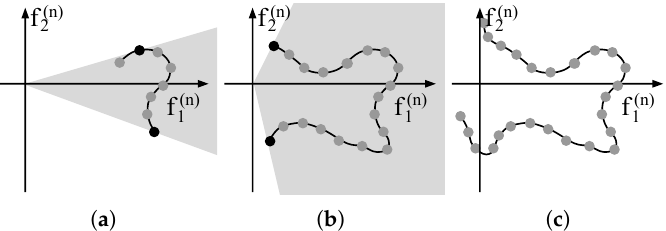
Figure 4. ( a ) illustrative case of projection of local manifold samples M ( n ) on a basis B ( n ) , for K = 2. The curved line represents the projection of a continuous one-dimensional manifold, while the dots represent the projection of the samples (columns of M ( n ) ) on B ( n ) . When ∆ is sufficiently small, ( n ) the projections have single-signed, relatively large values on the first component f and smaller 1 values on the remaining components. In this case, the definition of a first-order cone (represented by the shadowed region) is possible and can be used in the reconstruction algorithm combined with a non-negativity constraint for the first component, ensuring that the recovered coefficients represent weighted copies of the local manifold, rather than other arbitrary combinations. The upper and lower ( n ) ( n ) ( n ) ) and min ( f ( n ) ) , respectively; ( b ) as ∆ increases, angles of the cone depend on max i ( f / f / f i 2, i 1, i 2, i 1, i the angle of the cone may as well increase, making the constraint less effective, as a broader area is allowed for the recovered coefficients f ( n ) ; ( c ) an example where the definition of a convex cone is no longer possible. This imposes a limit on the definition of ∆